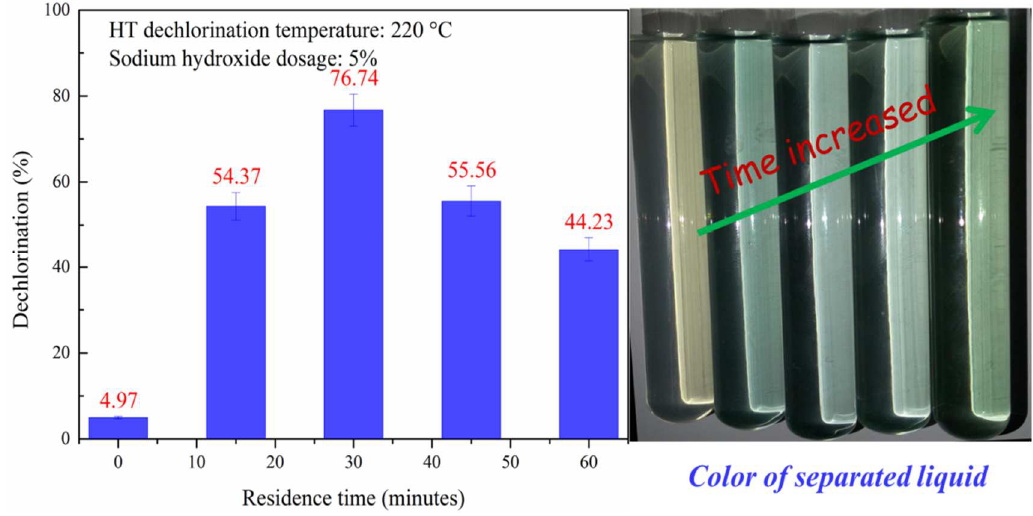
Figure 3. Effect of residence time on HT dechlorination of PVC.